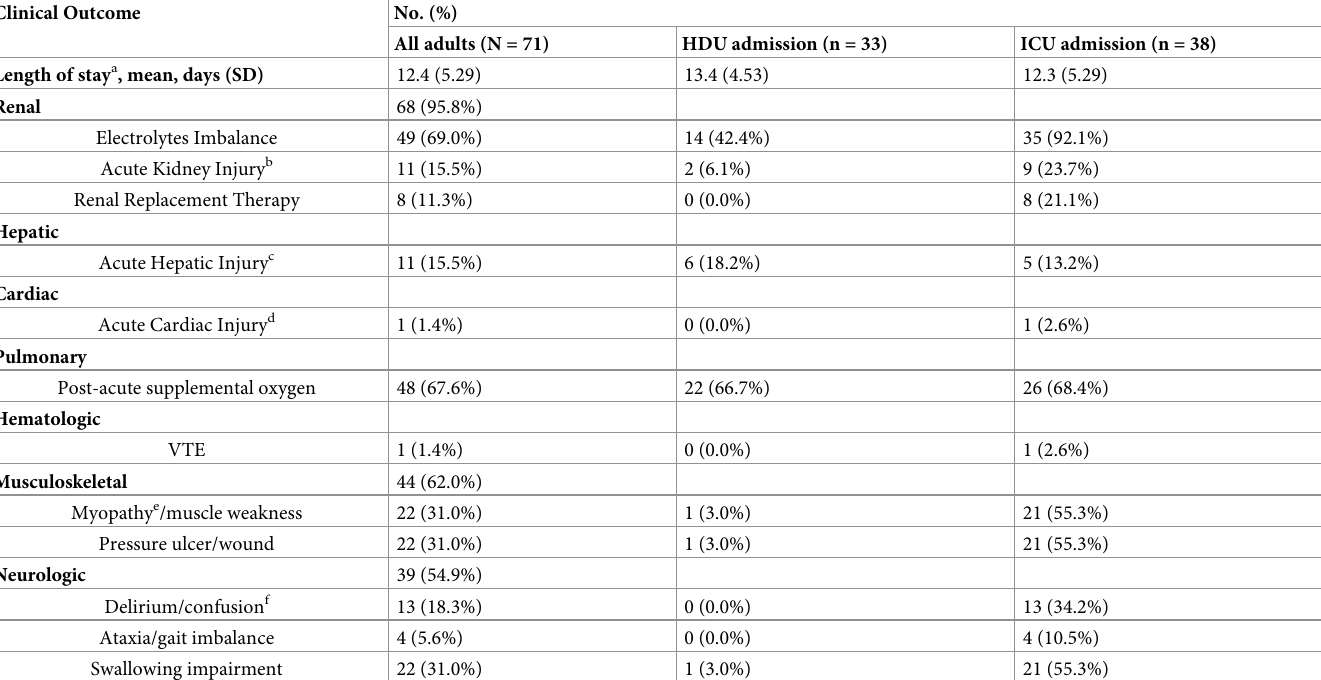
Table 4. Post-infectious and post-acute complications of COVID-19 patients transferred out of critical care units. Clinical